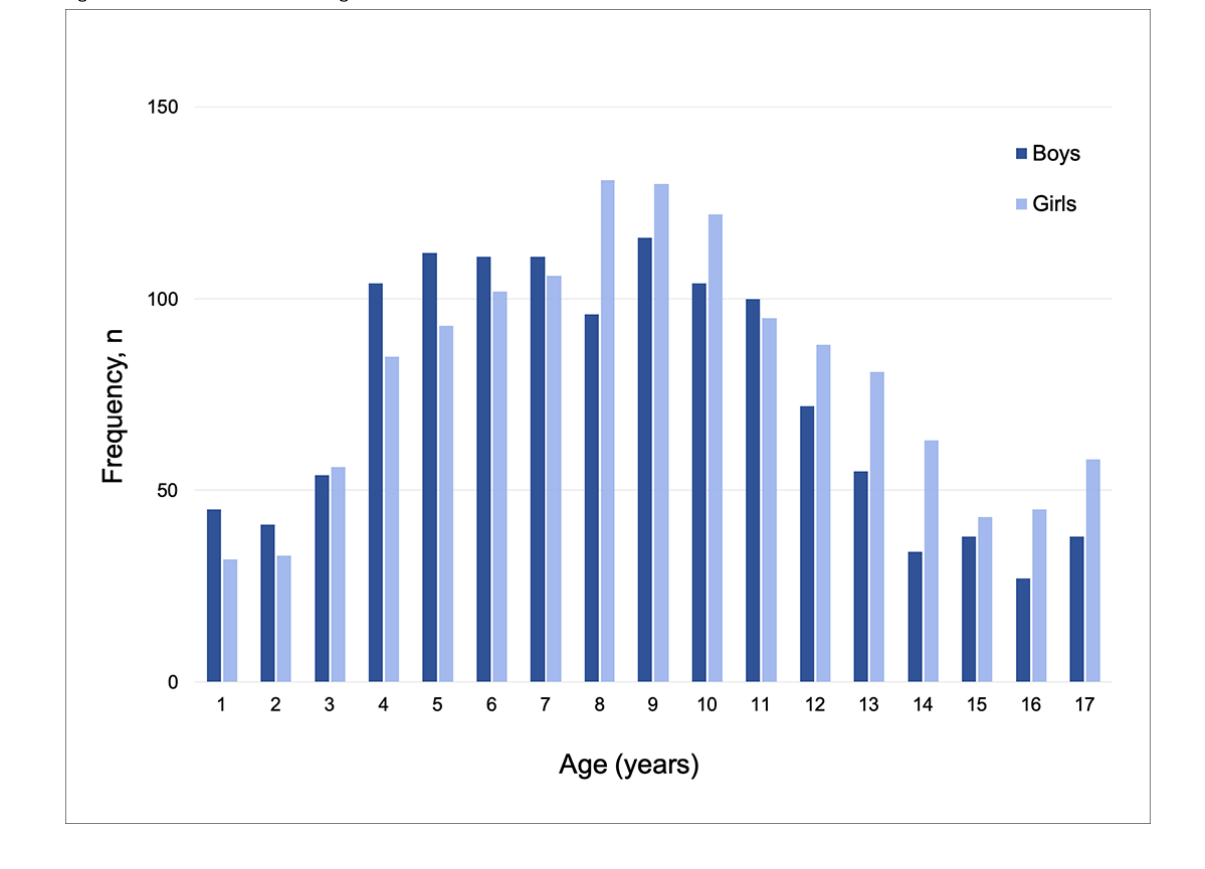
Figure 1. Age distribution of children using Calm.